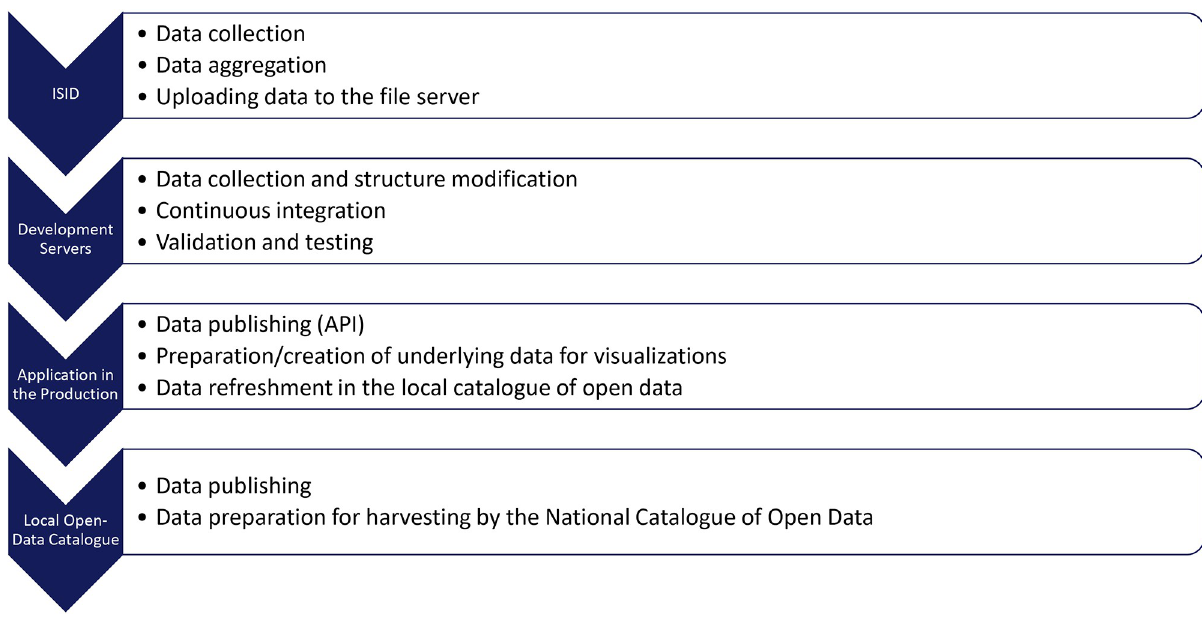
Fig 2. The process of data processing and